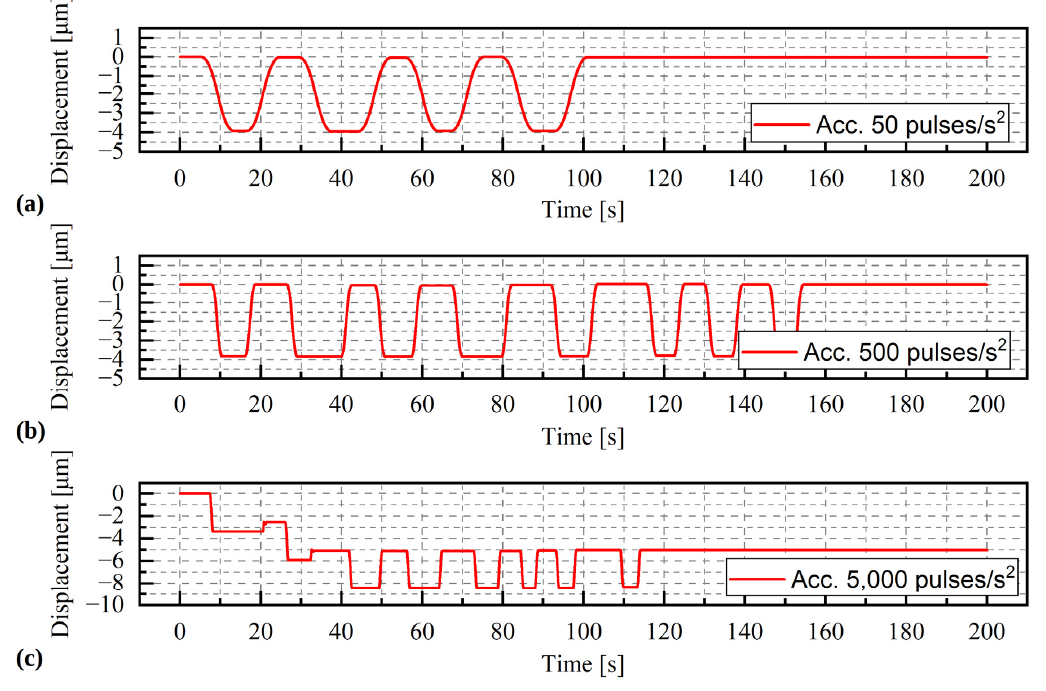
Figure 11. Displacement of the stepper motor with a load of 14.72 kg. During the test the accelera- tion was change ( a ) acceleration = 50 pulses/s 2 , ( b ) acceleration = 500 pulses/s 2 , ( c ) acceleration = 5000 pulses/s 2 .